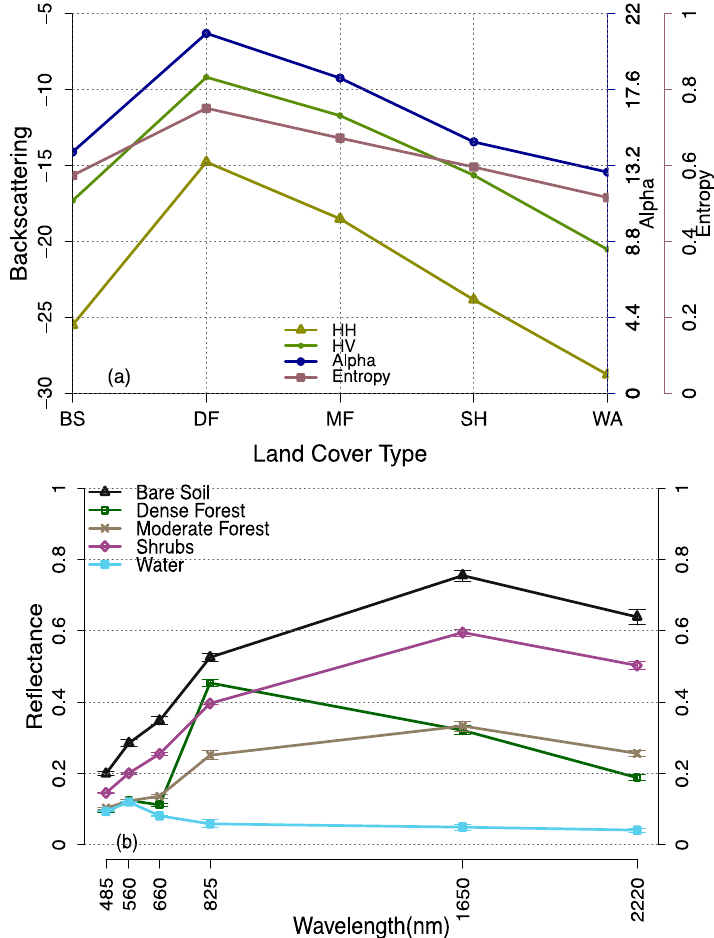
Figure 5. ( a ) ALOS PALSAR (HH, HV), Alpha and Entropy responses; ( b ) Landsat 5 TM surface reflectance profile patterns. The backscattering coefficients, alpha, entropy and surface reflectance values are extracted based on the training samples of various land cover classes under study (Figure